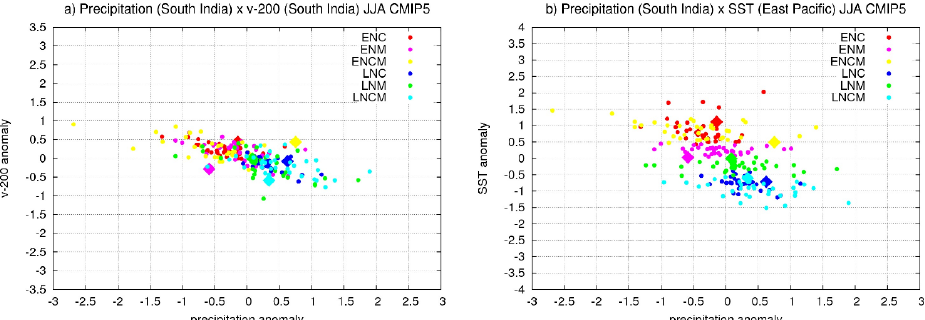
Figure 6. S Region: ISM precipitation (mm/day) vs. various fields. Precipitation vs. local atmospheric influence of wind (m/s) is shown for V200 ( a ). Precipitation vs. remote influence from East Tropical Pacific SST (°C) ( b ) is also shown.